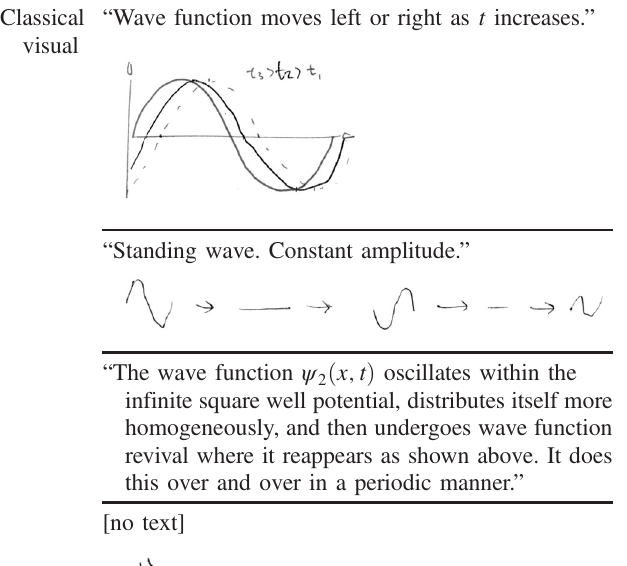
TABLE I. Examples of student responses coded as either classical visual or quantum visual. All examples are responses to pre- and midtest question 1a (Fig. 3). Classical visual